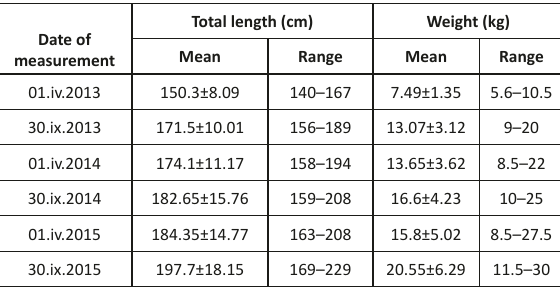
Table 1. Mean total length and weight of 20 Gharials recorded with respect to warm and cold seasons from April 2013–September 2015.